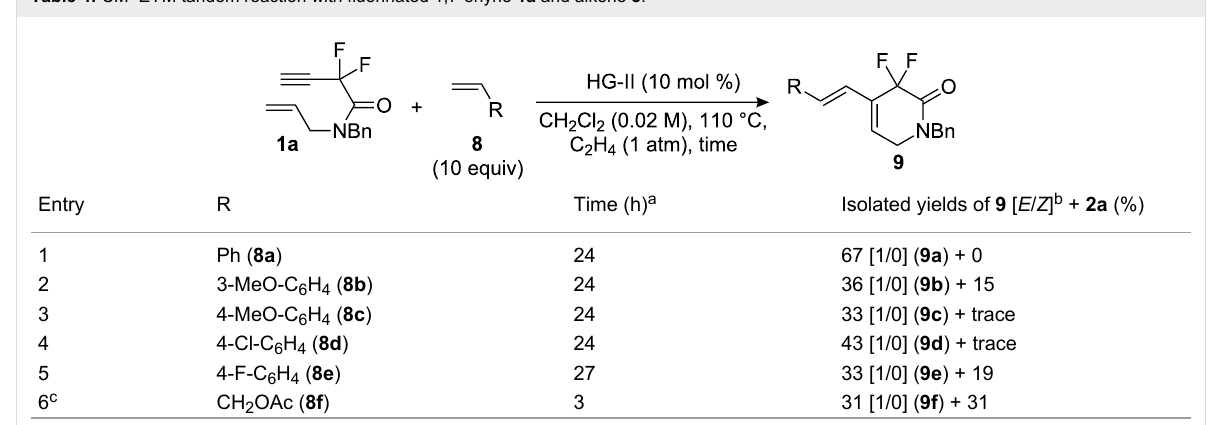
Table 4: CM–EYM tandem reaction with fluorinated 1,7-enyne 1a and alkene 8